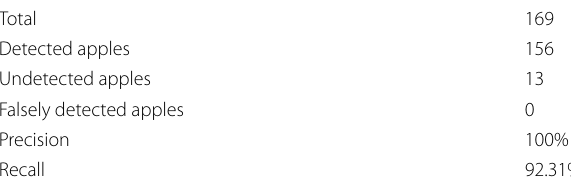
Table 4 Result of the apple position